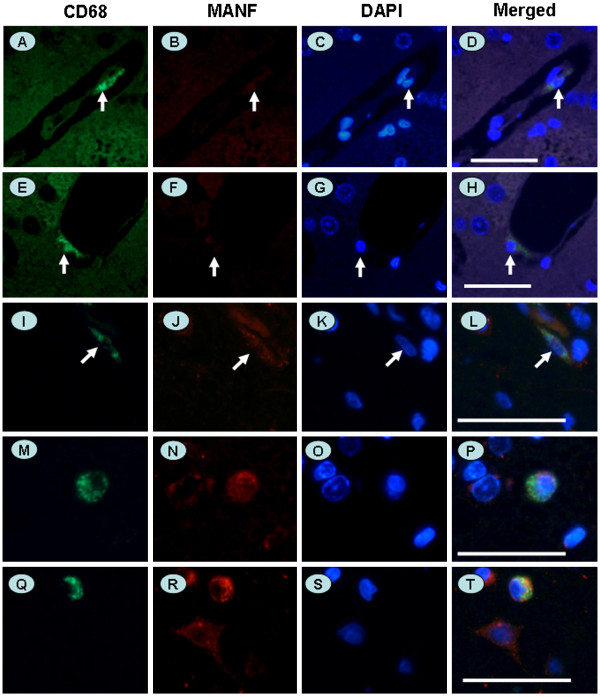
Differential expression of mesencephalic astrocyte-derived neurotrophic factor in the microglia in brain tissue. (A to D) A rod-shaped microglial cell within blood vessel in the normal cerebral cortex. (E to H) A ramified microglial cell under vascular endothelium in the normal cerebral cortex. (I to L) A rod-shaped microglial cell with weak mesencephalic astrocyte-derived neurotrophic factor (MANF)-positive immunoreaction in the ischemic cerebral cortex. (M to P) An amoeboid microglial cell with MANF-positive immunoreaction in the ischemic cerebral cortex. (Q to T) A round microglial cell with strong MANF-positive immunoreaction in the ischemic cerebral cortex. Microglial cells were identified with anti-CD68 antibody (green, A, E, I, M, and Q). MANF was detected with monoclonal anti-MANF (red, B, F, J, N, and R). Nuclei were stained by 4′,6-diamidino-2-phenylindole (blue, C, G, K, O, and S). Scale bar = 50 μm.